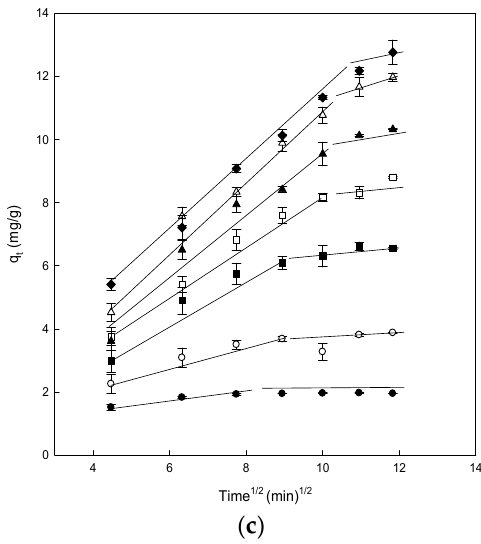
Figure 4. ( a ) Pseudo-first-order model plots, ( b ) pseudo-second-order model plots, and ( c ) intraparticle diffusion model plots for the Direct Blue 78 adsorption onto eggshell at different concentrations of dye of 25 mg/L ( ● ), 50 mg/L ( ○ ), 100 mg/L ( ■ ), 150 mg/L ( □ ), 200 mg/L ( ▲ ), 250 mg/L ( Δ ), and 300 mg/L ( ♦ ). Table 1. Kinetics parameters of the pseudo-first-order, pseudo-second-order, and intraparticle diffusion models for the adsorption of Direct Blue 78 onto eggshell. PFOM